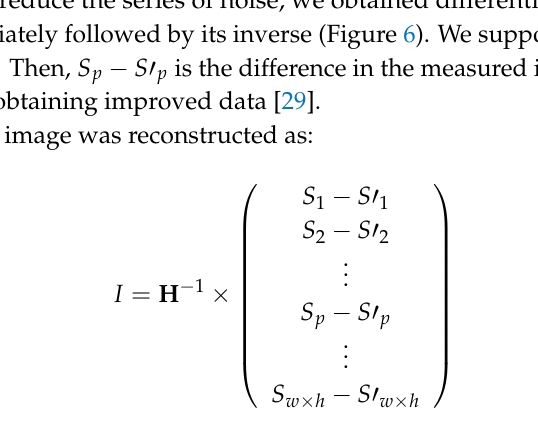
Figure 6. Original Hadamard mask and its inverse: ( a ) the original Hadamard mask and ( b ) the inverse of ( a ).